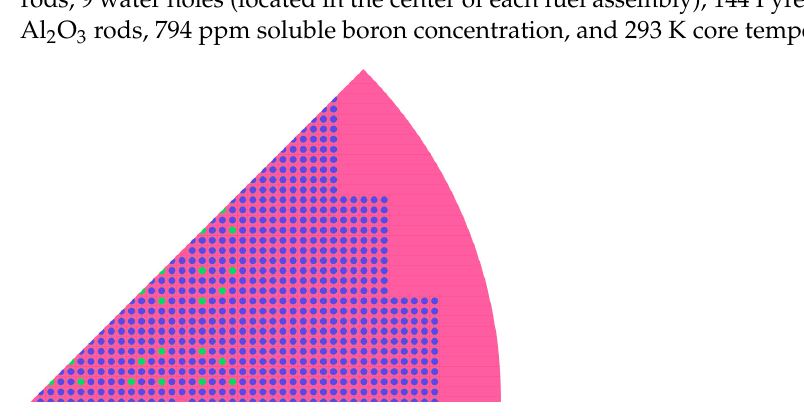
Figure 2. B&W’s Core XI 1/8 core.